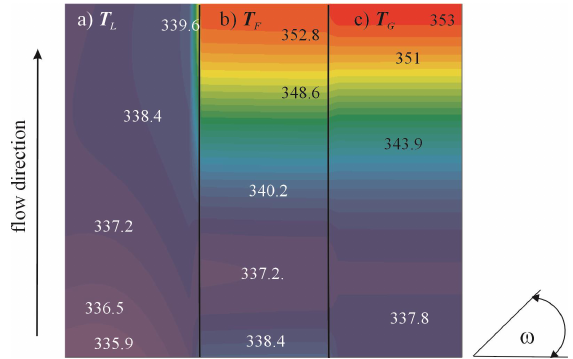
Fig. 3. Two-dimensional temperature fields determined by the Trefftz method for a)the glass plate T G , b) the heating foil T F , c) the liquid T L . Additional data as in Fig. 2 for q V =1.97·10 5 kW/m 3